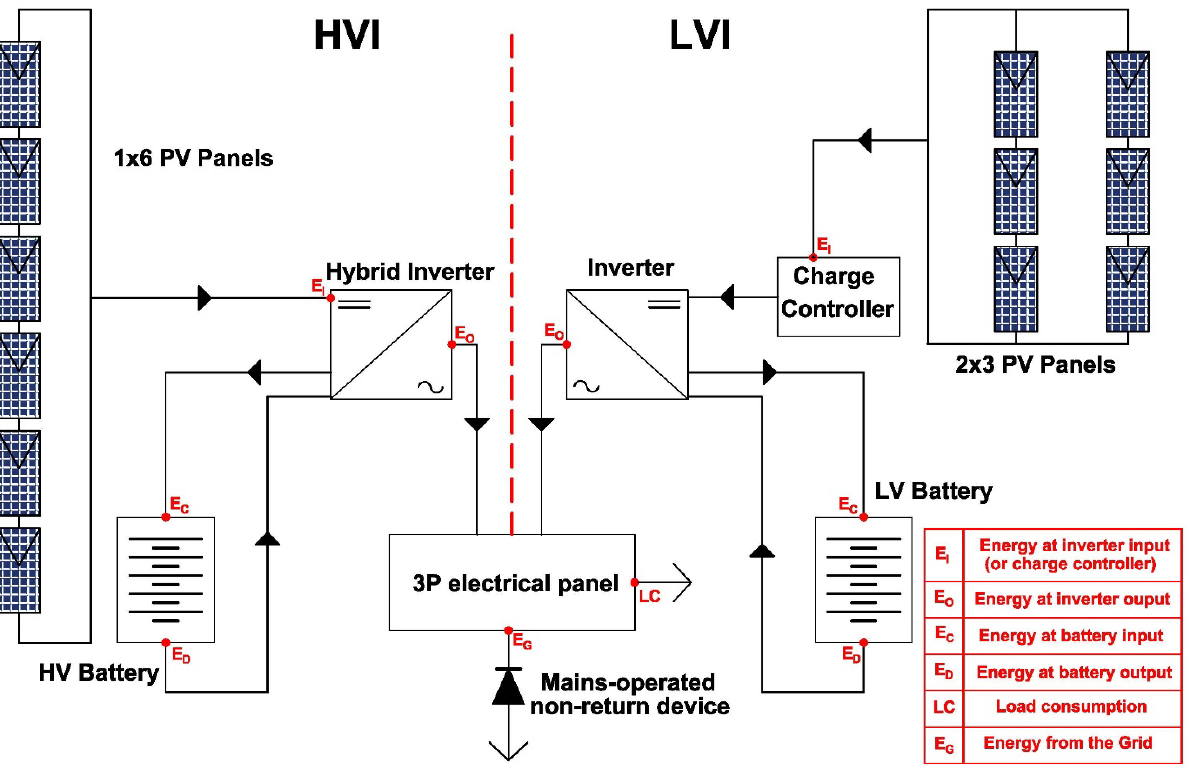
Figure 3. Schematic layout of the prototype.